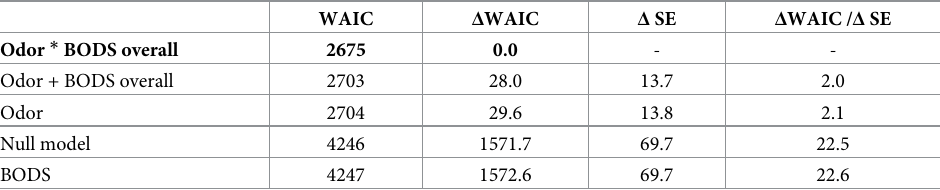
Table 4. Model comparison for models predicting valence